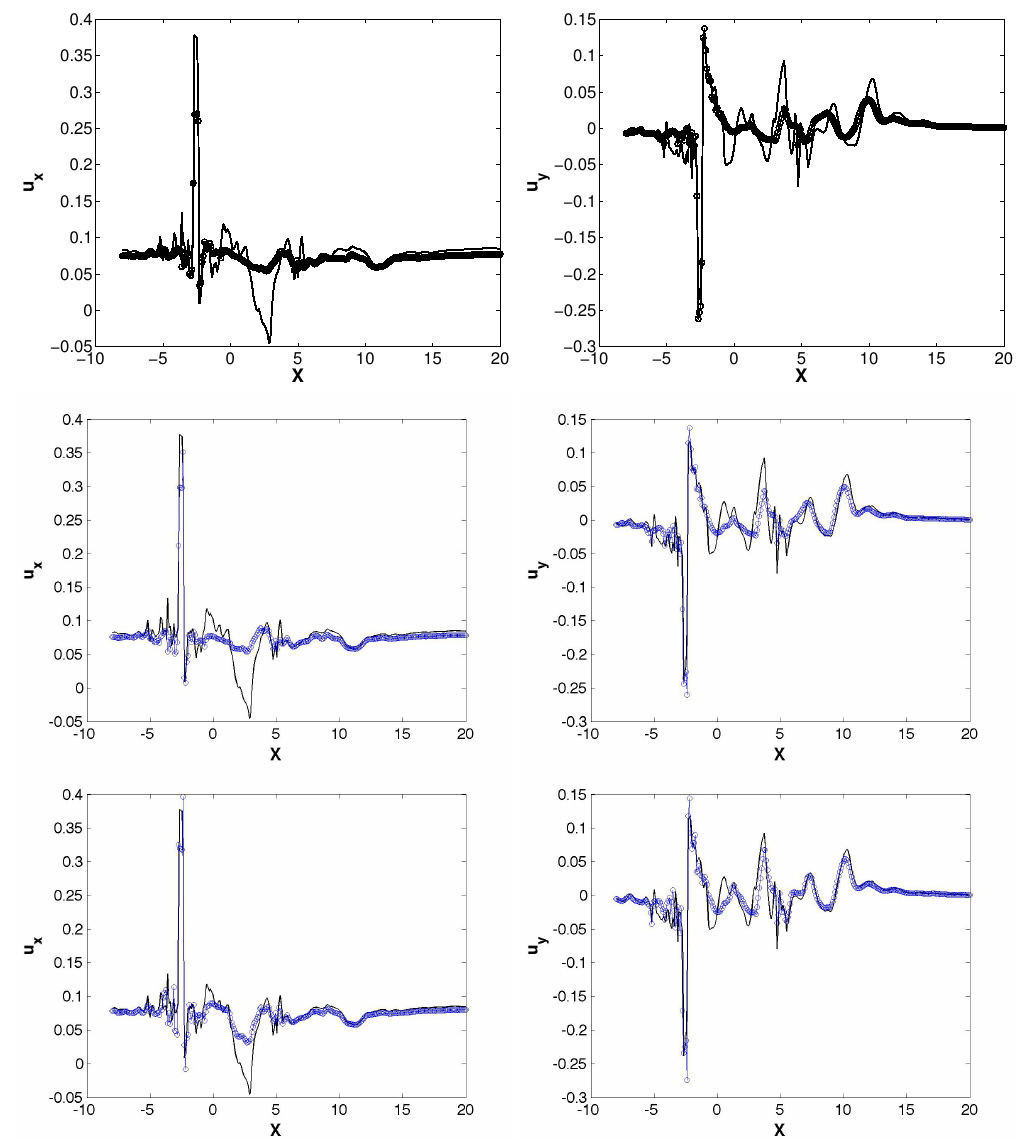
Figure 8. Counterpart of Figure 7 in y = −